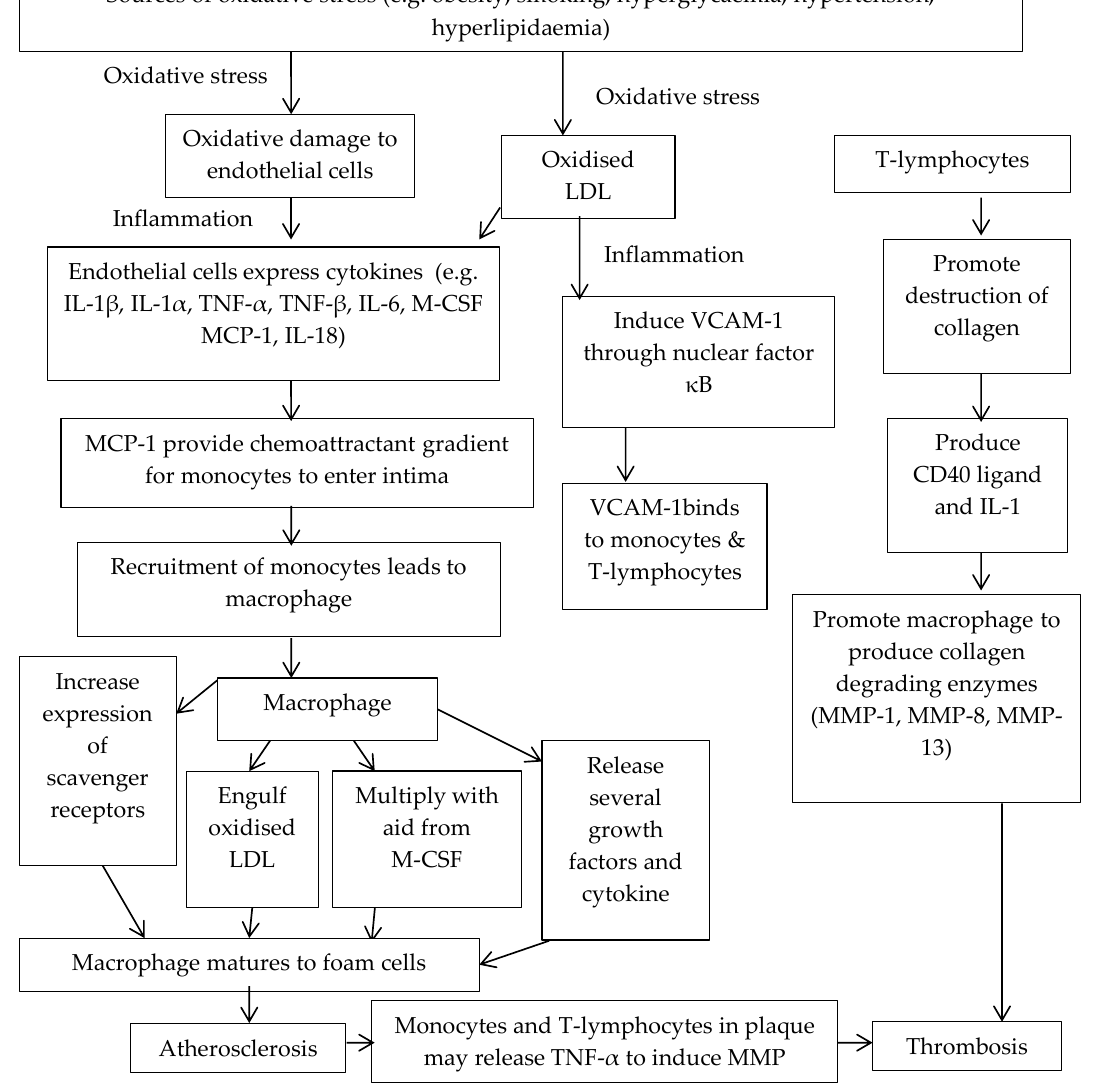
Figure 1. Atherosclerosis pathway involving oxidative stress (OS) and inflammation [4,5]. Abbreviations: LDL—low density lipoprotein. IL-1β—interleukin-1beta. IL-1α—interleukin-1alpha.